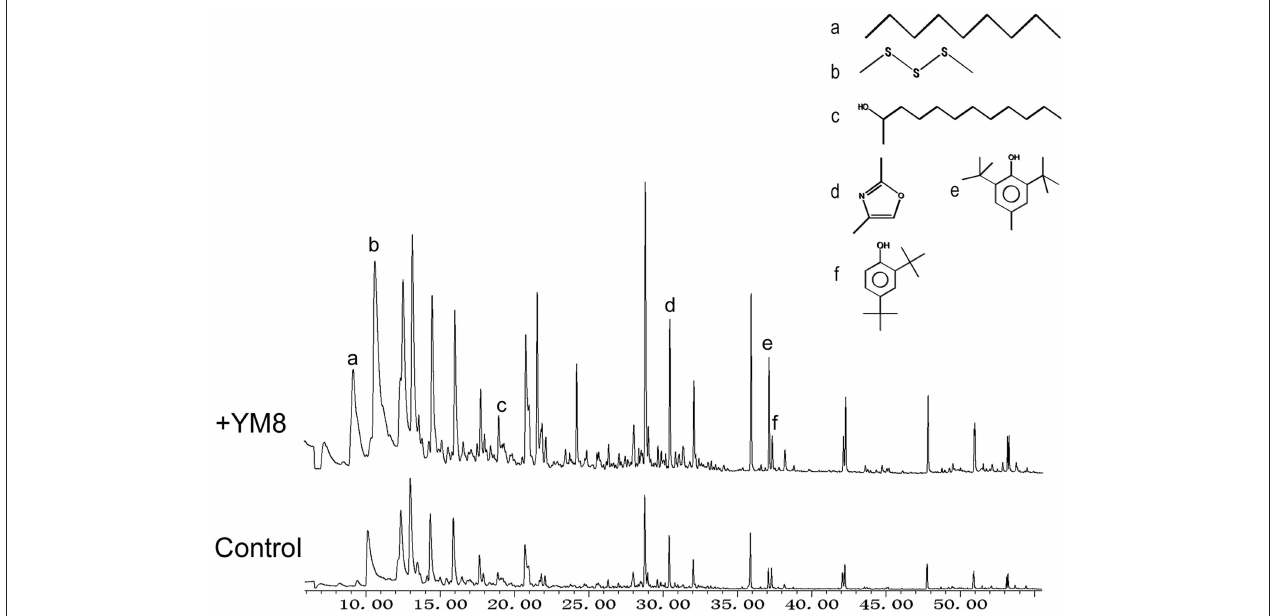
FIGURE 3 | GC-MS spectra of volatiles emitted from strain YM8. Bacterial strain YM8 grown on NA plates for 48h and control NA medium. Detected volatile organic compounds (VOCs) are listed in Table 1 . Chemical structures of six selected VOCs: a, nonane; b, dimethyl trisulfide; c, 2-dodecanol; d, 2,4-dimethyl-oxazole; e, butylated hydroxytoluene; f,